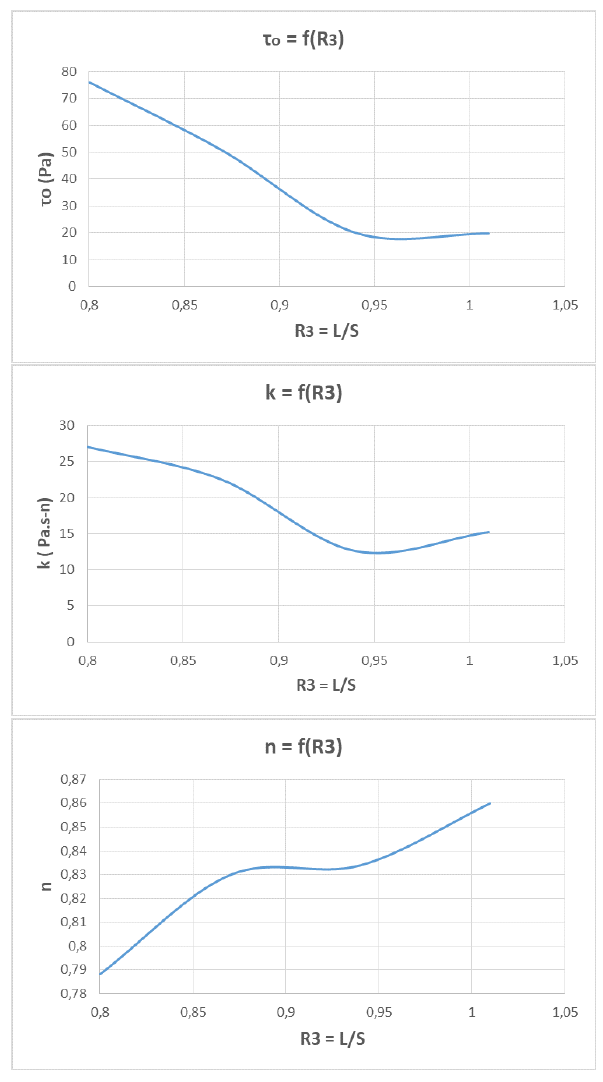
Figure 11: Effect of L/S on the rheological parameters